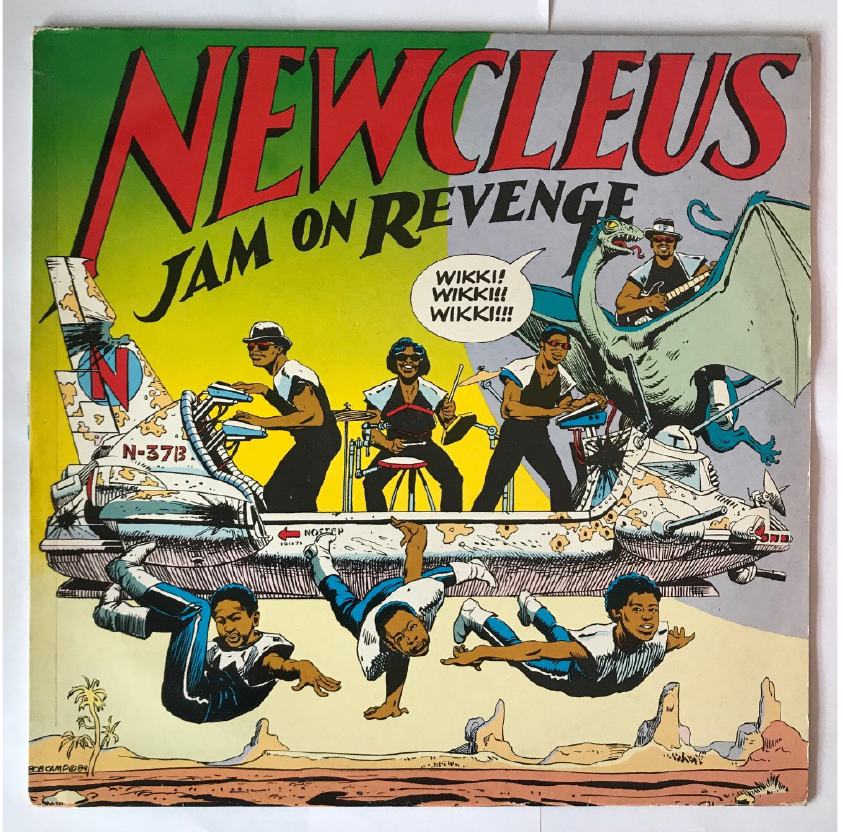
Figure 2: Front cover of “Jam on Revenge” illustrated by Bob Camp. Photograph by author. This visual delight was not only for Newcleus’ consumers and fans, as Cozmo D recalls: “I loved it; I was into comic books, I knew who Bob Camp was, he did Conan (The Barbarian) and I loved Conan. I was thrilled that an actual Marvel artist was doing our albums” (Cozmo D, i/v, Skype, 12 th October